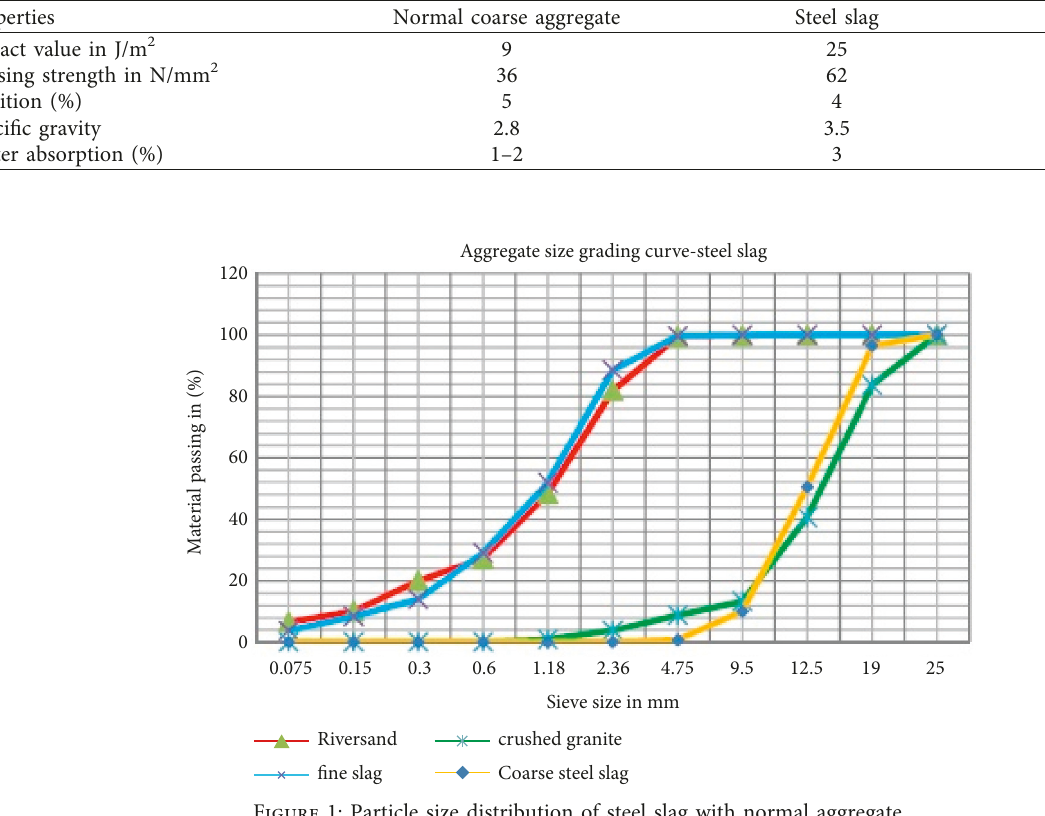
Table 1: Properties of steel slag and normal coarse aggregate.